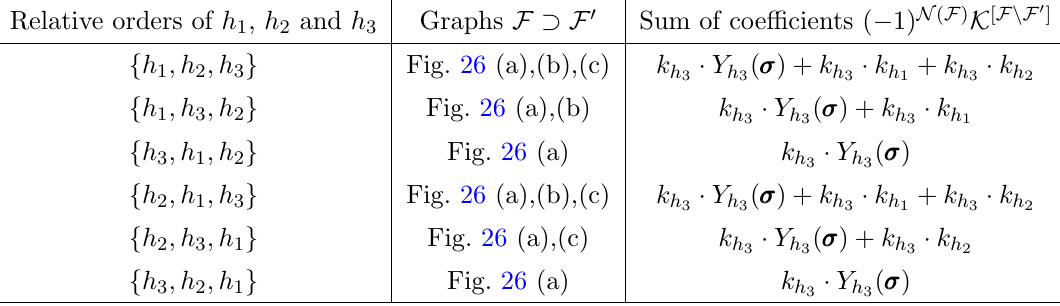
Figure 26 . All graphs containing the skeleton F 0 = (cid:12)gure 6